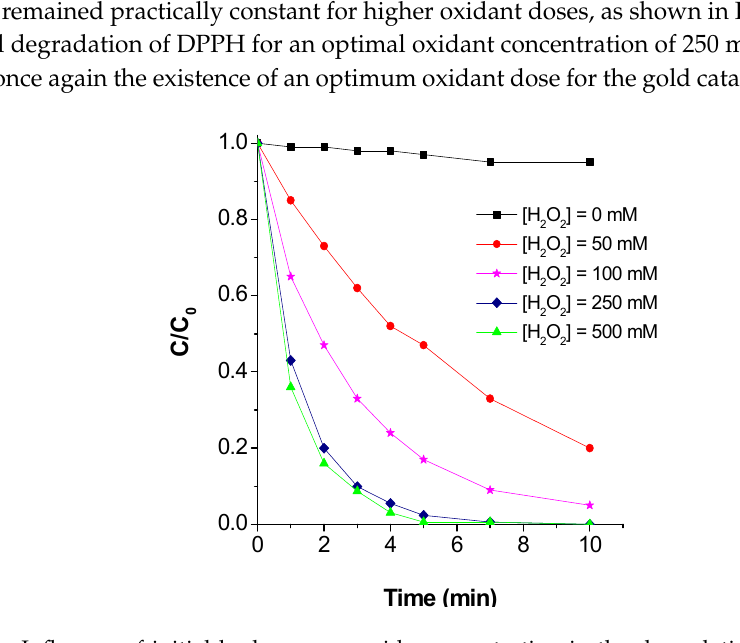
Figure 8. Effect of hydrogen peroxide concentration in dye and TOC removals and hydrogen peroxide consumption after 4 h of reaction (a) and hydroxyl radicals formation during CWPO (b) for a Au/Al 2 O 3 catalyst ([OII] a) = 0.1 mM or [OII] b) = 0.0 mM, [catalyst] = 2.0 g/L, T = 30 °C and pH initial = 3.0). Adapted from Rodrigues et al. [66]. Yang et al. [108] tested gold supported on carbon as a CWPO catalyst for the oxidation of BPA.